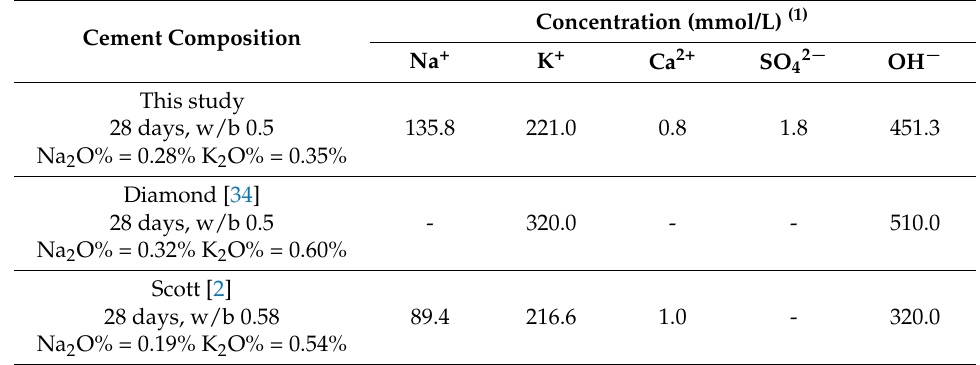
Table 7. Summary of chemical analysis of pore solutions